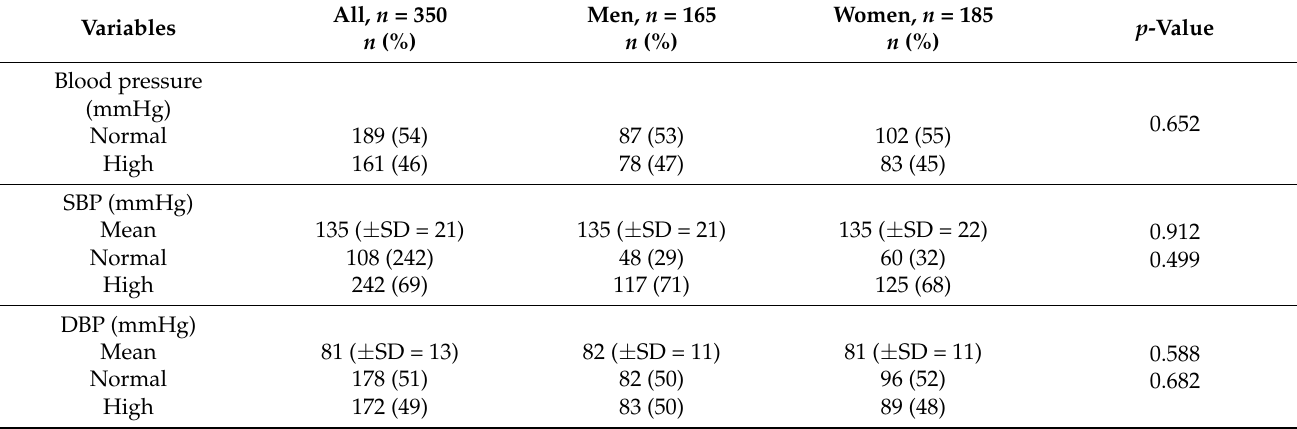
Table 2. Comparison of blood pressure and weight statuses of participants by